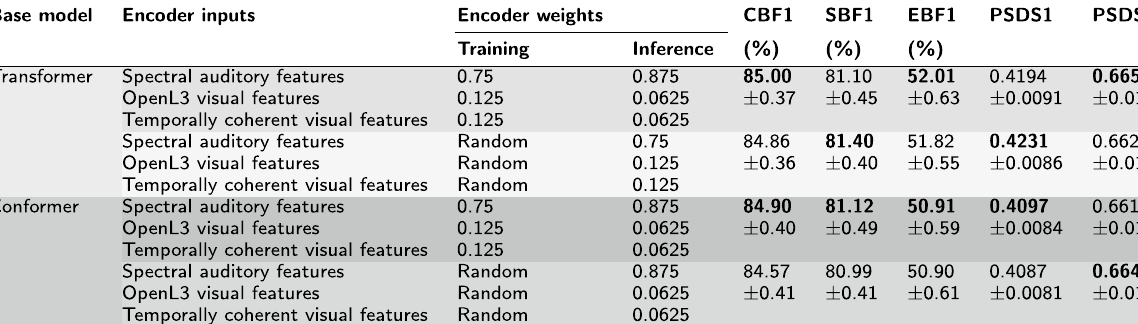
Table 8 Results of tri-encoder attention-based